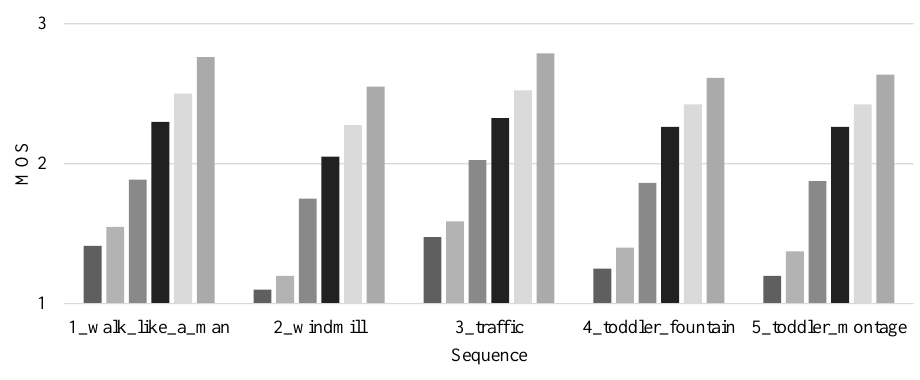
Figure 10. Subjective quality evaluation of processed video content with respect to SNR.